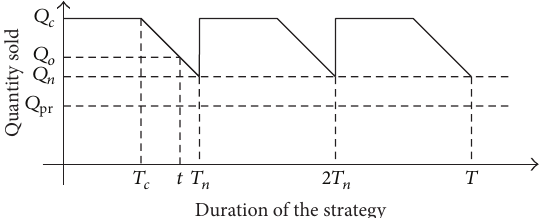
Figure 7: Modelling the situation when the sale price is constant and the quantity sold is